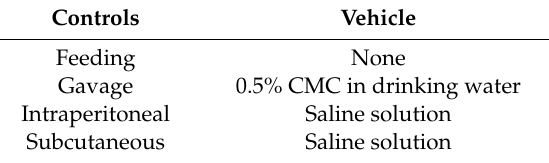
Table 3. Description of (vehicle)